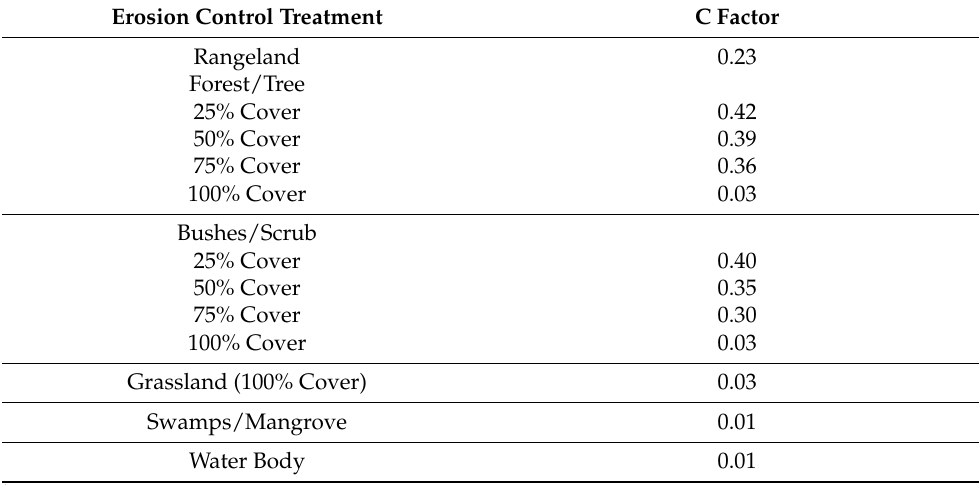
Table 3. Cover management, C factor, for forested and undisturbed lands 1 [18,20,27–29].